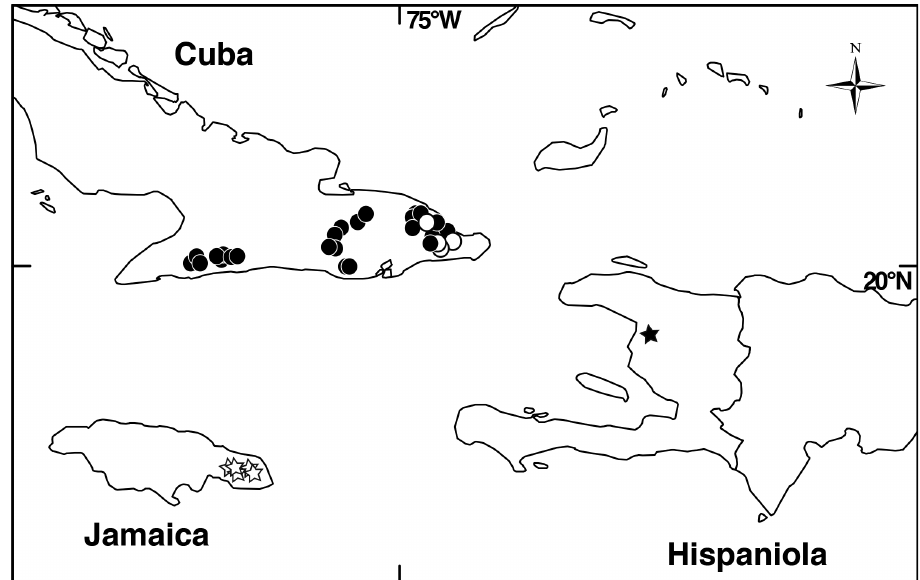
Figure 11. Distribution of M. asperifolia (open stars), M. hybophylla (closed star), M. argentimuricata (closed circles), and M. bullotricha (open